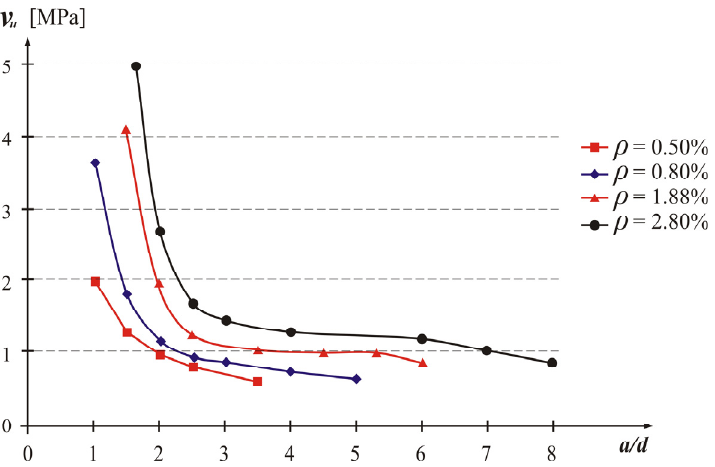
Figure 1. The influence of shear span-to-depth ratio on shear capacity on the basis of test results presented in [6].